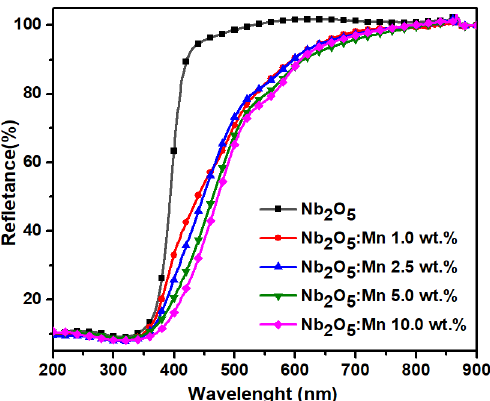
Figure 7. Diffuse reflectance spectra as a function of wavelength of samples submitted at 700 ◦ C, by varying Mn